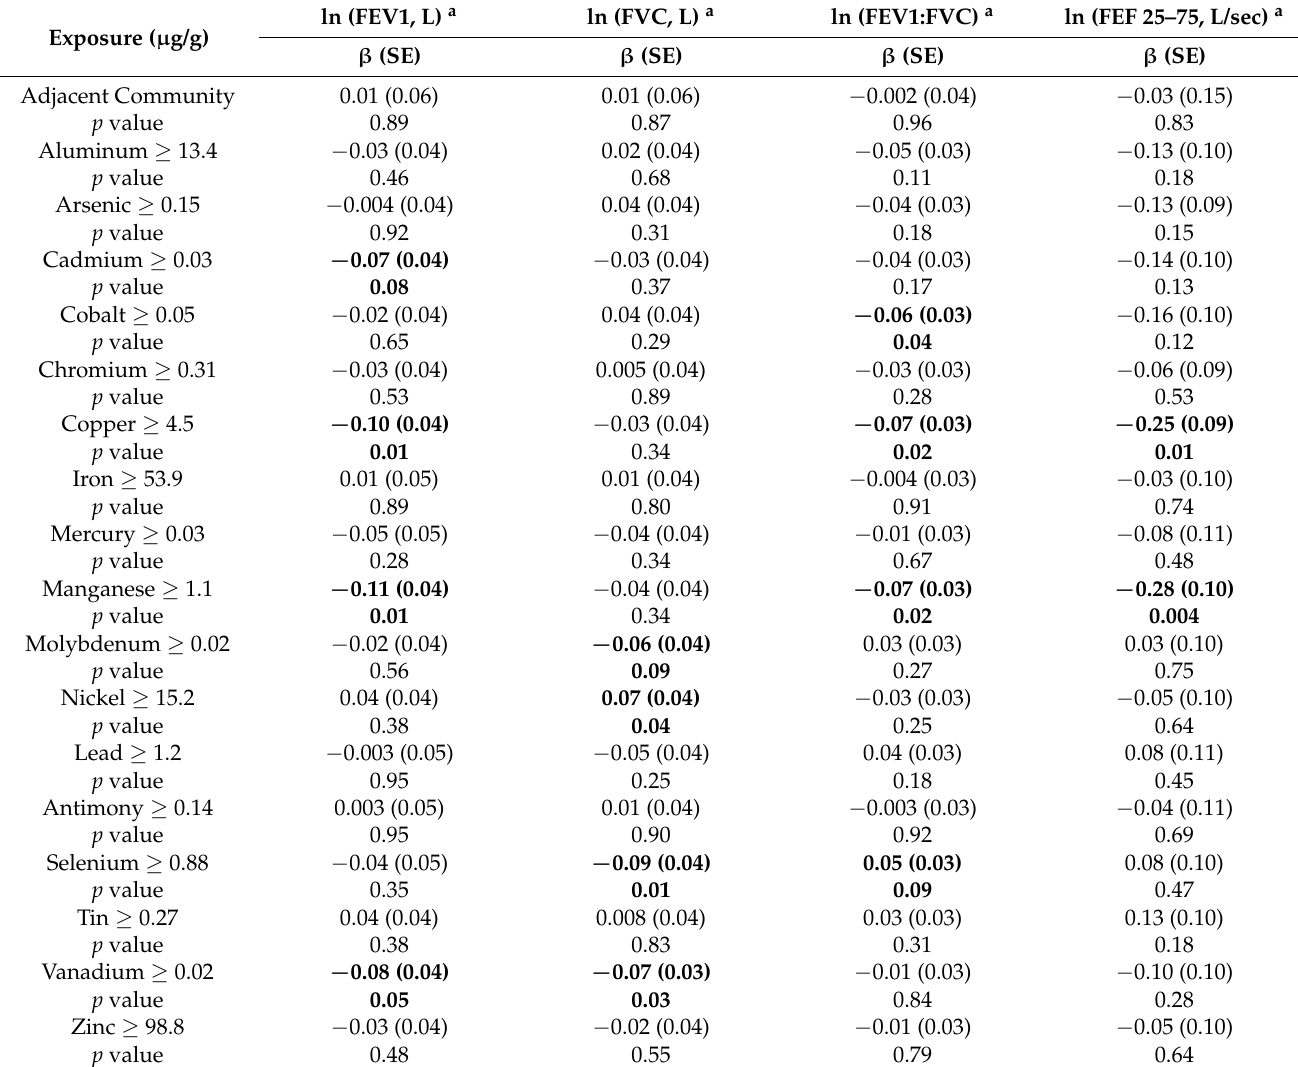
Table 3. Associations between toenail metal concentrations and pulmonary function parameters among children with asthma ( n =